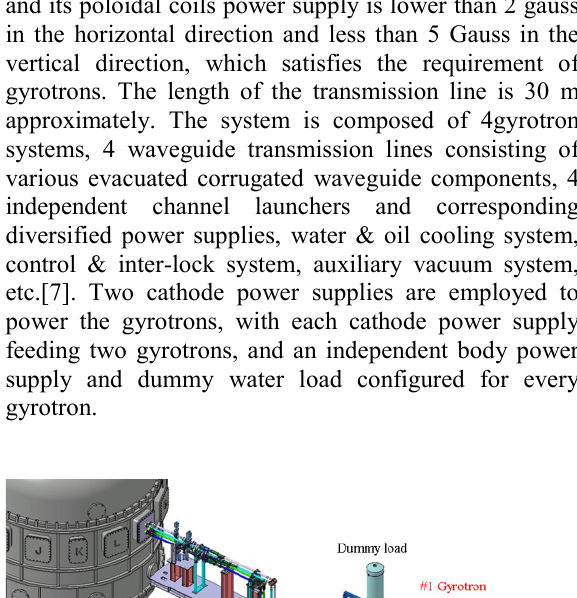
Table 1. Main parameters of